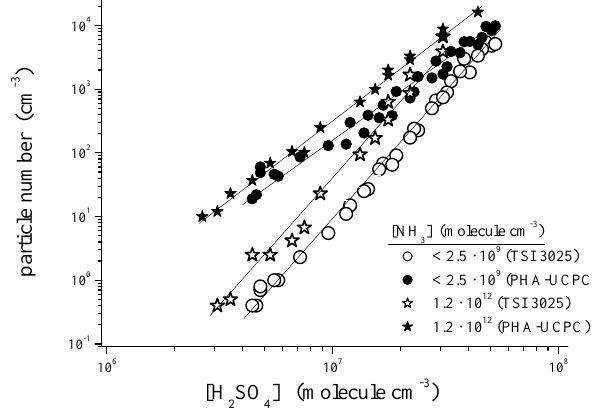
Fig. 10b. Particle numbers as a function of H 2 SO 4 concentration in absence and presence of NH 3 addition; total gas flow: 30lmin − 1 STP. Relative humidity: